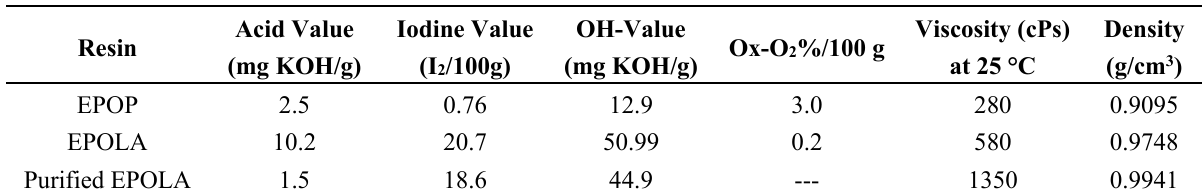
Table 1. Physio-chemical characteristics of EPOP and